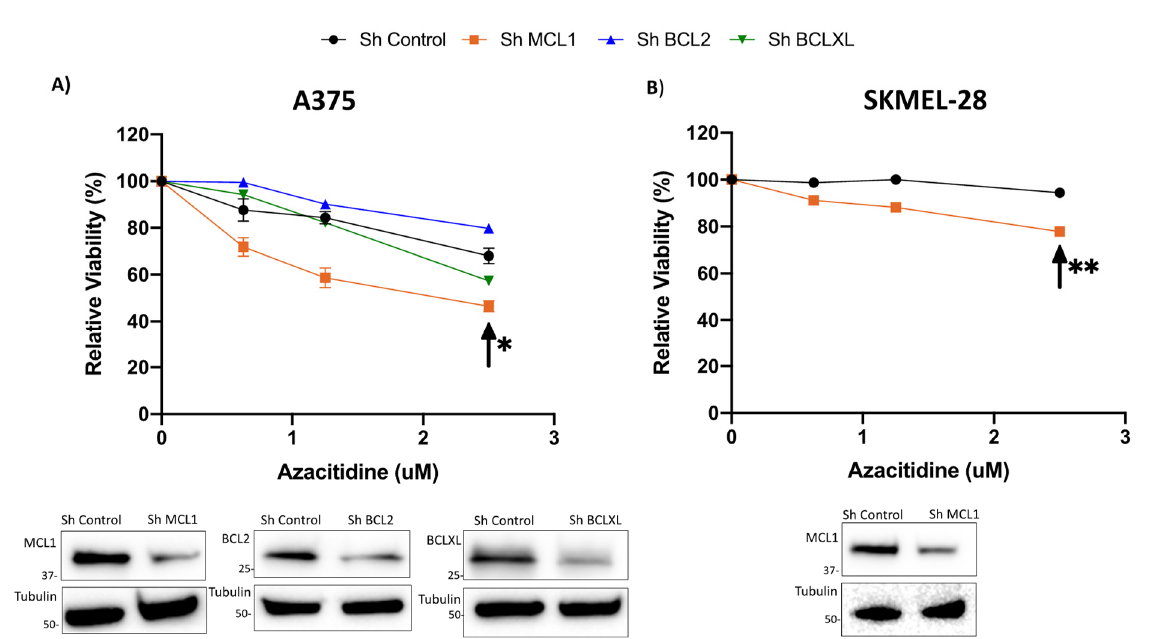
Figure 2. Knockdown of MCL1 or BCLXL sensitizes cells to single agent AZA treatment; knockdown of BCL2 has no effect on AZA sensitivity. ( A ) Knockdown A375 cell lines of BCL2, BCLXL, and MCL1, ( B ) Knockdown SKMEL-28 cell line of MCL1. ( A , B ) Knockdown cell lines were treated with AZA 0 uM- 2.5 uM for 48 h. Knockdown of MCL1 significantly sensitized cells to treatment with single agent AZA. Arrow indicates significance compared to sh Control. * indicates p < 0.05, ** indicates p < 0.01. Y axis indicates viability relative to DMSO control, set to 100%. X axis indicates AZA dosage. Immunoblot with control and knockdown cell lysates indicate knockdown of the target proteins. Error bars represent +/ − SEM.